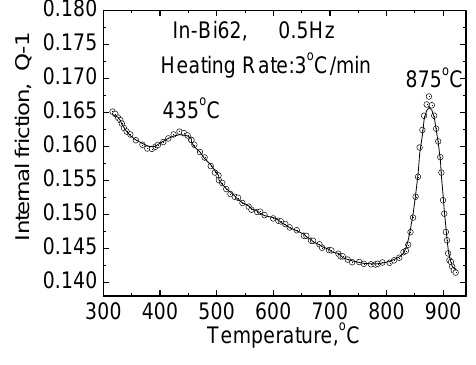
Figure 4. Q −1 - T behavior of the melt